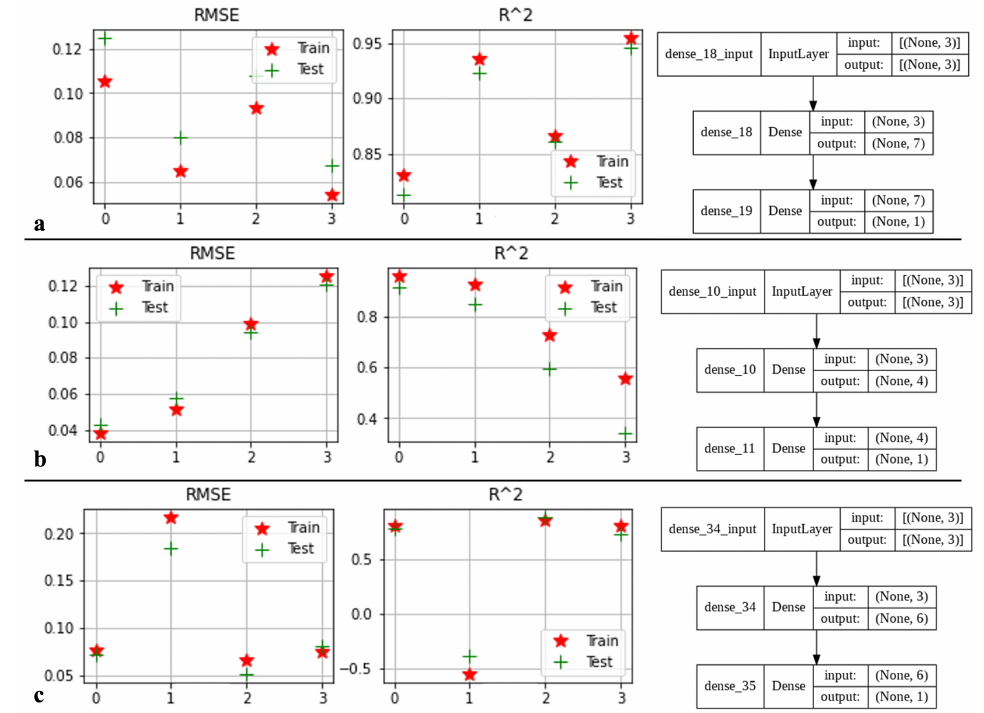
Figure 13. Different scenarios using ANN for ( a ) B x , ( b ) B y , and ( c ) B z